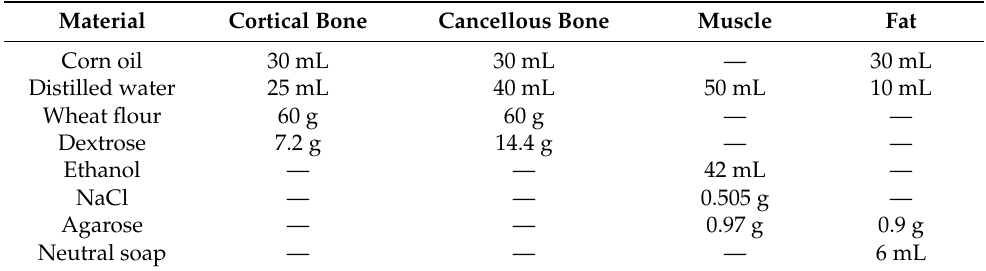
Table 5. Materials and concentrations used to develop the multi-layer phantom tissue.